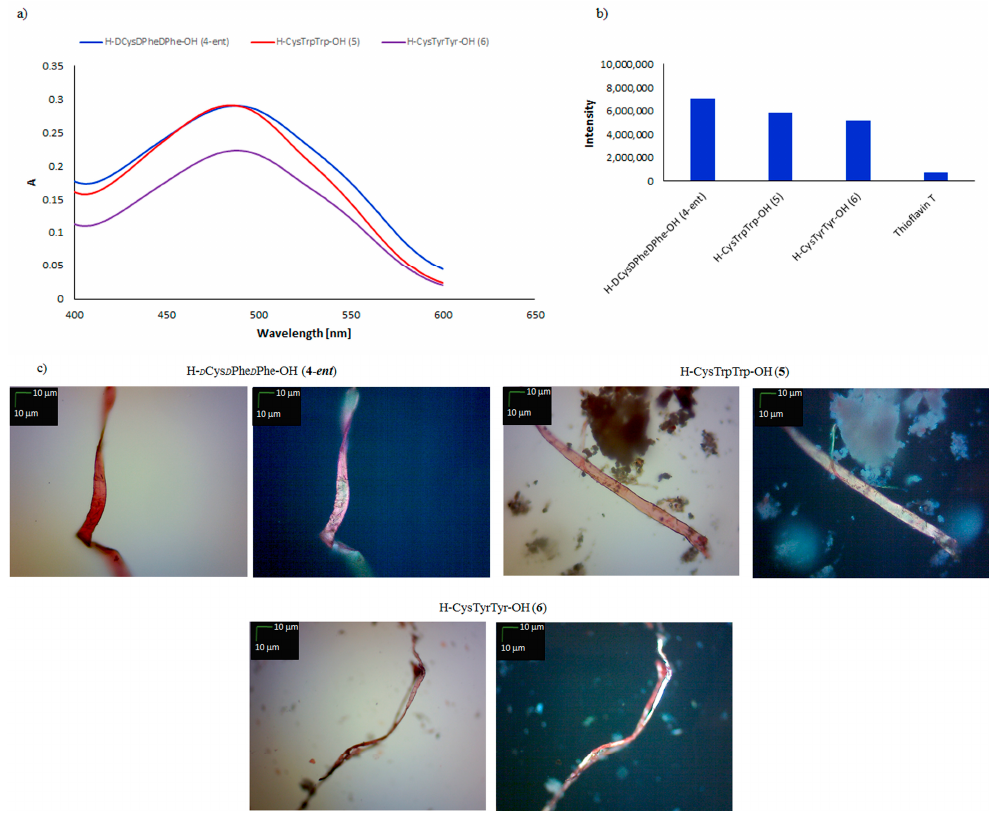
Figure 2. ( a ) UV-Vis spectra of CR in the presence of H– D Cys D Phe D Phe–OH ( 4- ent ),